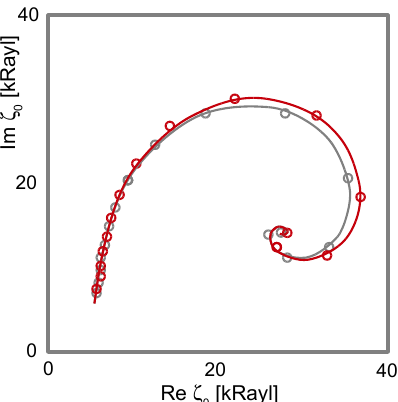
Figure 18. An experimental example of a film resonance. The sample consisted of a polyelectrolyte multilayer, the thickness of which was gradually increased by repeated dipping. When displayed in polar form, the data form a spiral. These authors display the load impedance rather than the complex frequency shift. The load impedance here has the unit “Rayl”, in the honor of John William Strutt, 3rd Baron Rayleigh. 1 MKS-Rayl is equal to 1 kg/(m 2 s). Red and black data denote results obtained with an even number of layers and with an odd number of layers, respectively. The difference occurs because anionic and cationic layers alternate. Adapted from